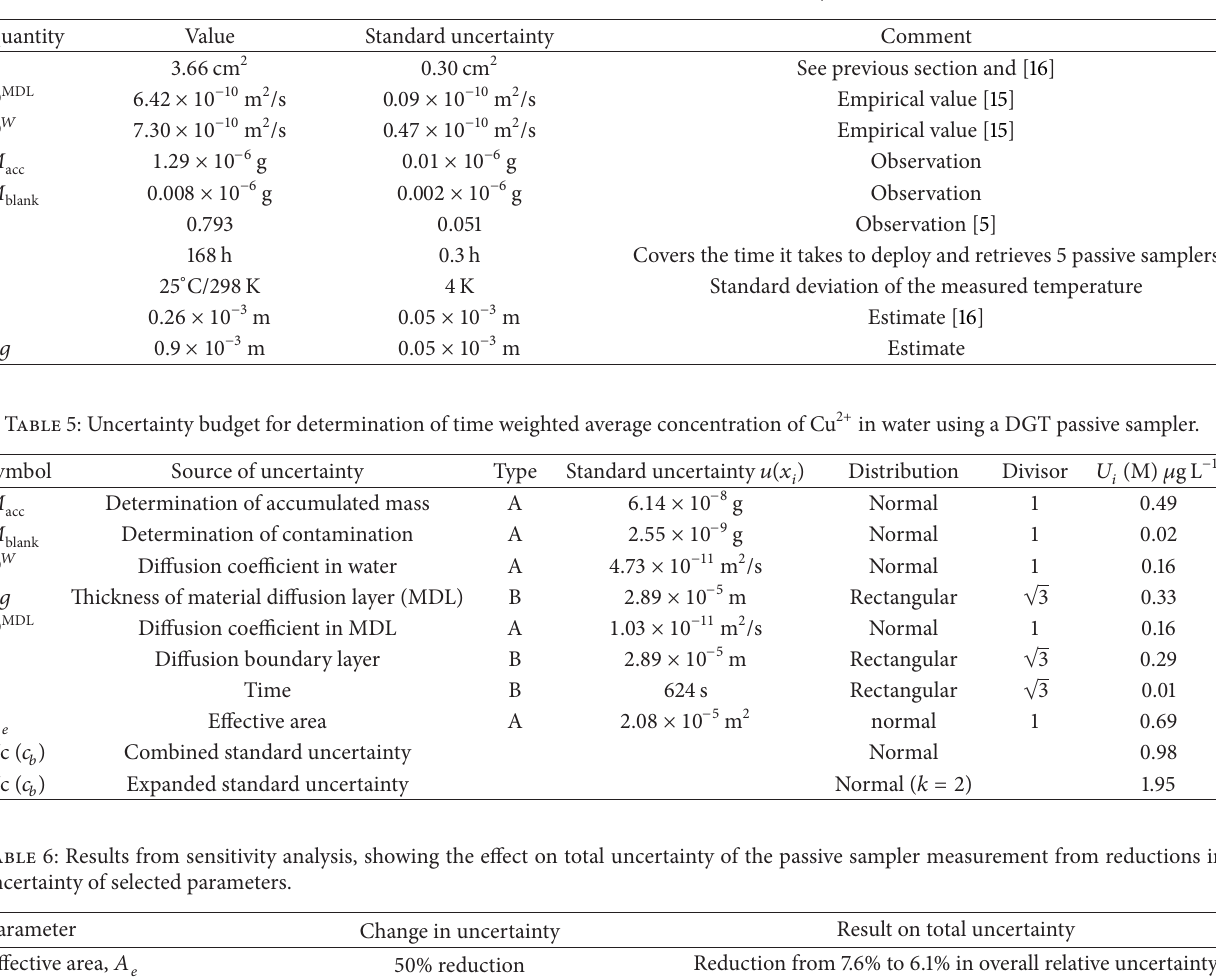
Table 4: Quantities, nominal values, and their associated uncertainty used in this work.